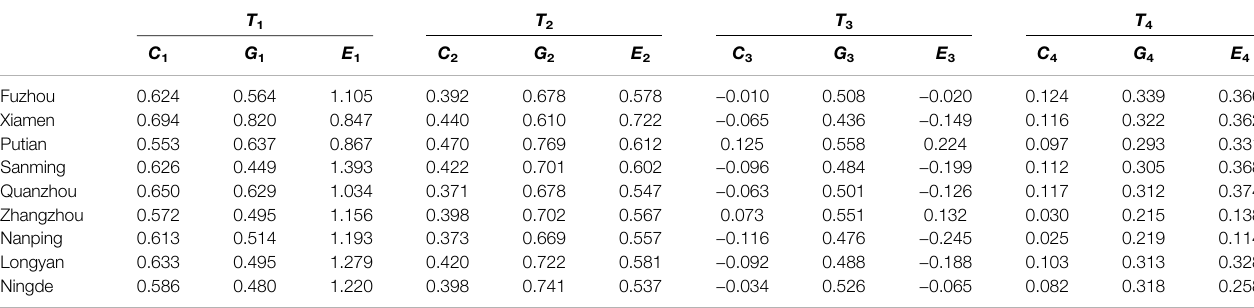
TABLE 3 | Decoupling elasticity index of prefecture-level cities in Fujian Province from 2001 to 2020.